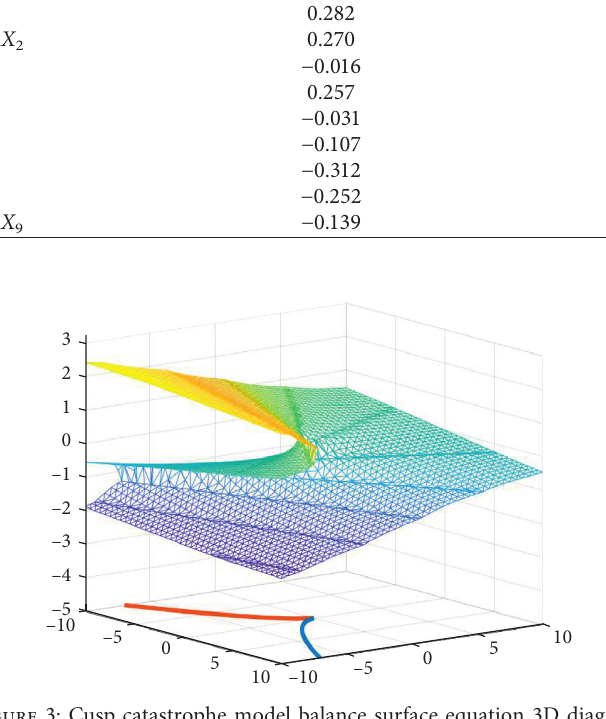
Figure 3: Cusp catastrophe model balance surface equation 3D